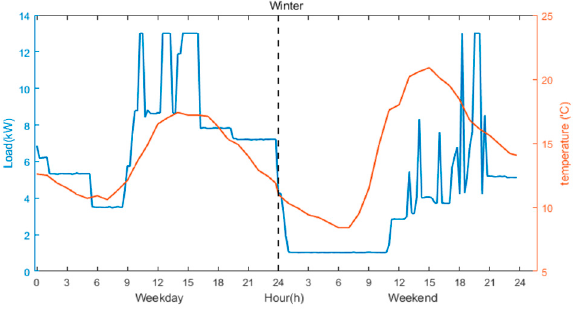
Figure 4. Energy consumption variations with temperature.